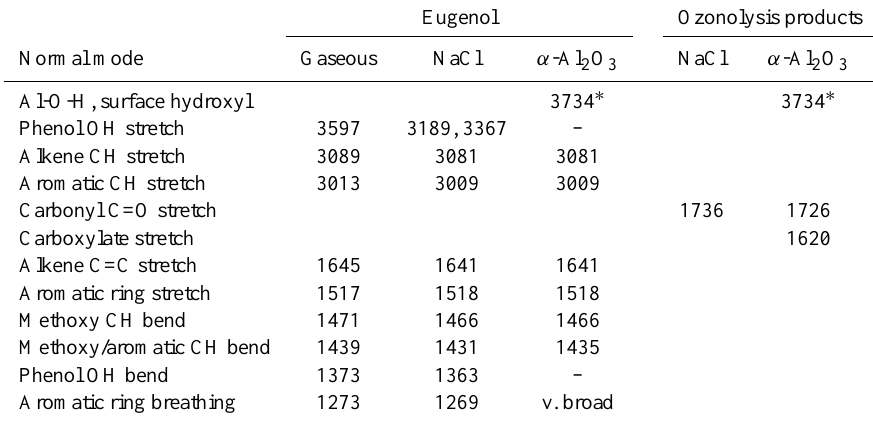
Table 1. Vibrational assignments (cm − 1 ) for eugenol and its ozonolysis products.